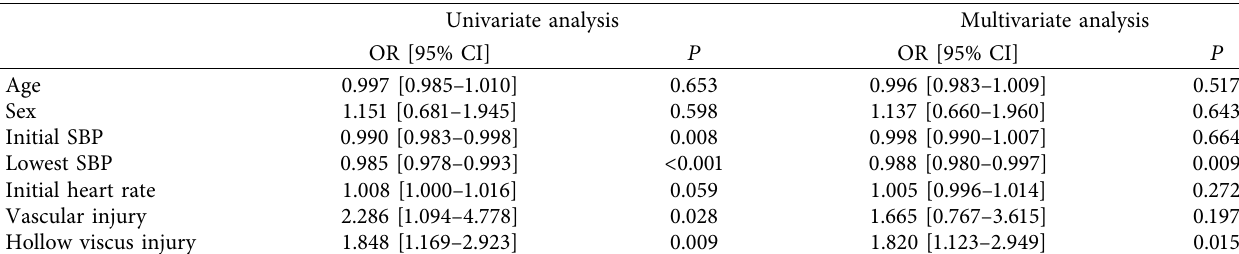
Table 4: Univariate and multivariate analyses of factors associated with true-positive